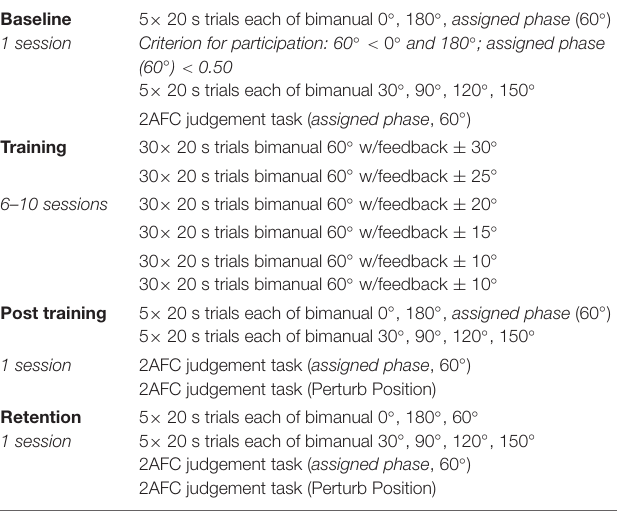
1 Hz. This block structure was then repeated for 180 ◦ and 60 ◦ relative phase, in that